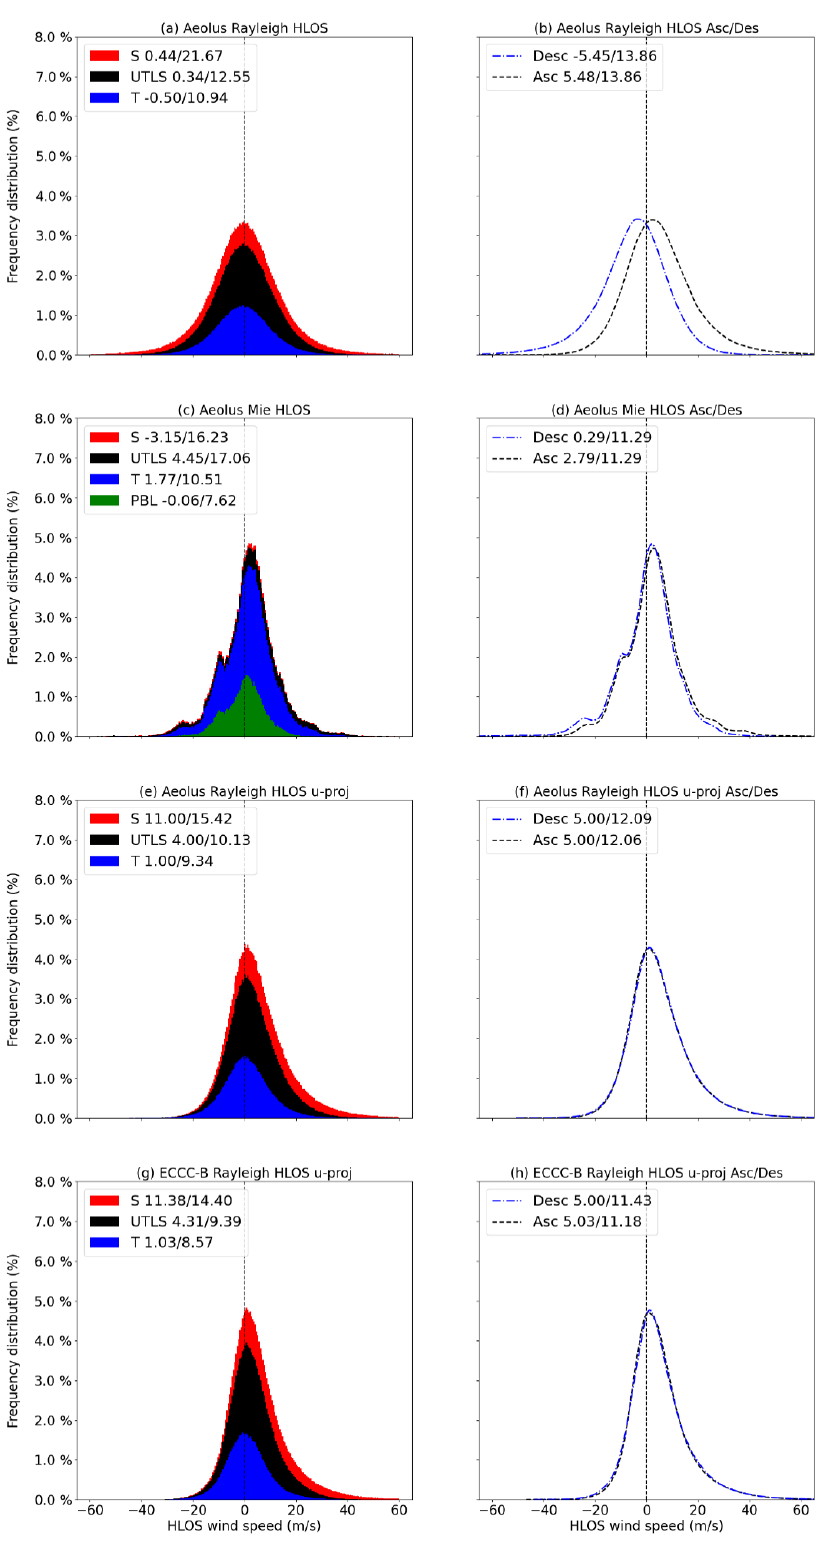
Figure 8. Aeolus Rayleigh (a, b) and Mie (c, d) HLOS measurement stacked frequency distributions (%) during winter 2020 over the Arctic ( > 70 ◦ N). The HLOS winds are projected onto the east–west directions (e–h) from Aeolus Rayleigh measurements and ECCC-B HLOS winds. The panels on the right show the distribution of ascending and descending measurements separately. The means and standard deviations of distributions in each atmospheric layer are listed in the figure